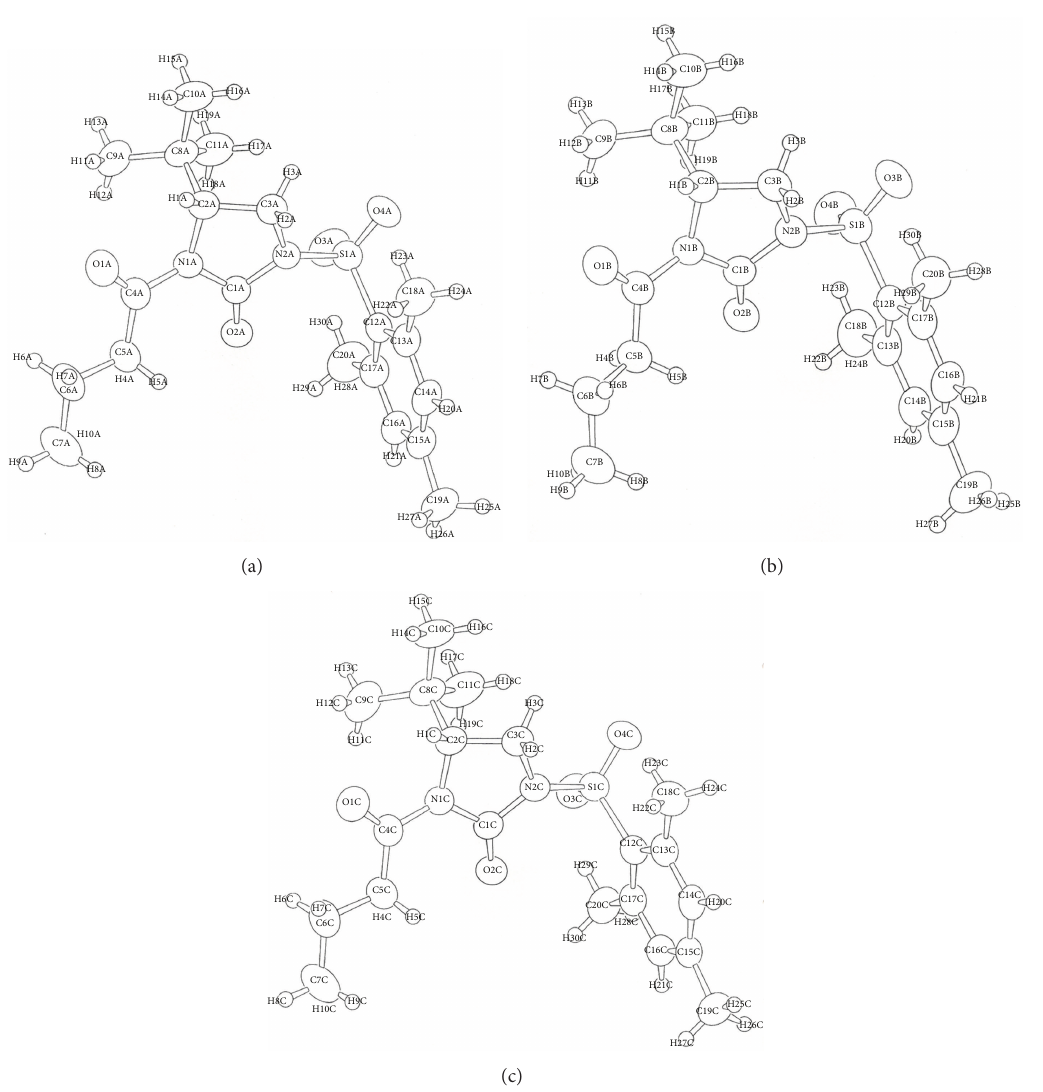
Figure 1: Numbering system of the three molecules ( 3A ; (a), 3B ; (b), and 3C ; (c)) of the X-ray structure of compound 3